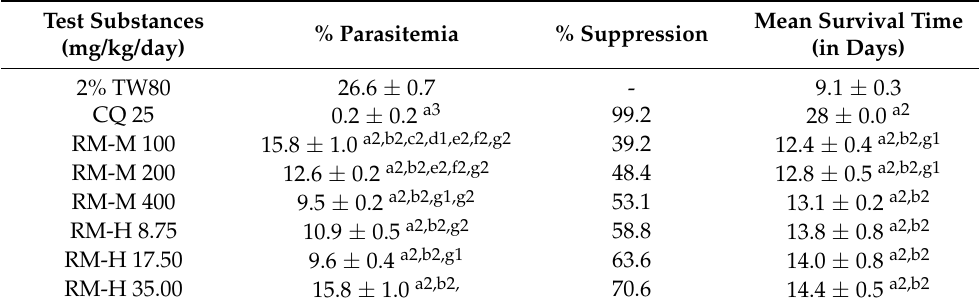
Table 1. Antimalarial activity of the leaf extracts of Ranunculus multifidus in mice infected with Plasmodium berghei in 4-day suppressive